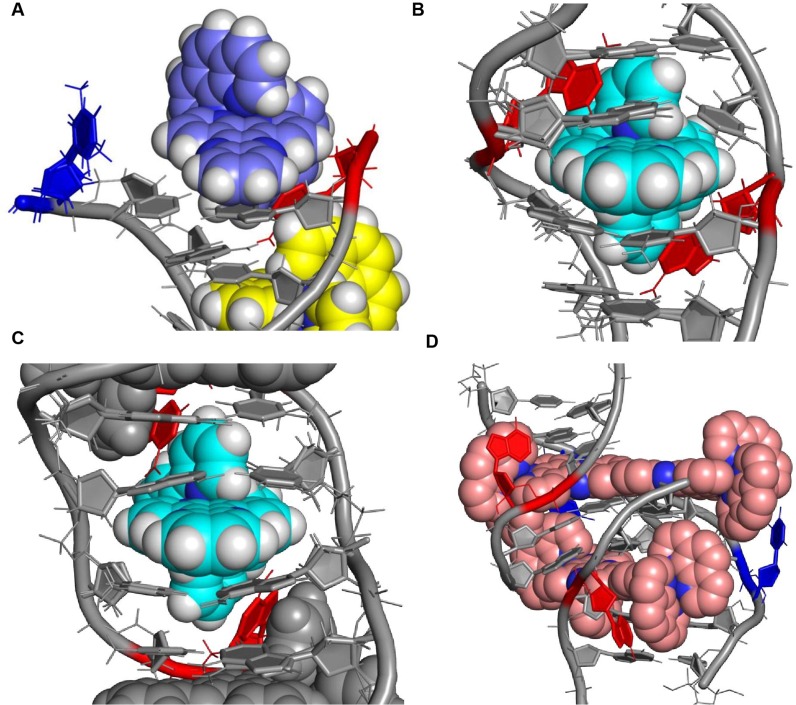
Views of four different Δ enantiomer binding sites in X-ray crystal structures. (A) The end-capping binding motif reported here. Adenine bases are illustrated in red with thymine in blue. As can be observed, adenine stacks onto a phen ligand whereas thymine stacks onto a symmetry related complex (not shown). Δ-[Ru(phen)2(dppz)]2+ is drawn in blue (B) Δ-[Ru(bpy)2(dppz)]2+ inserted into an A–A mismatch site (PDB ID 4E1U). The two mismatched adenine bases stack onto either bpy group. (C) Adjacent to the mismatch site, a second complex is bound by classical intercalation. The adenine bases from the mismatch site and a second mismatch site both stack onto the bpy groups of the intercalated complex, reducing intercalation depth. Δ-[Ru(bpy)2(dppz)]2+ is drawn in cyan. (D) Threading by Δ,Δ-[μ-(11,11′-bidppz)(phen)4Ru2]4+ into d(CGTACG)2, causing both an adenine and thymine to flip out of the DNA base stack (PDB ID 4GQJ). Both adenine and thymine stack onto the phen group in two separate complexes. Δ,Δ-[μ-(11,11′-bidppz)(phen)4Ru2]4+ is drawn in pink.